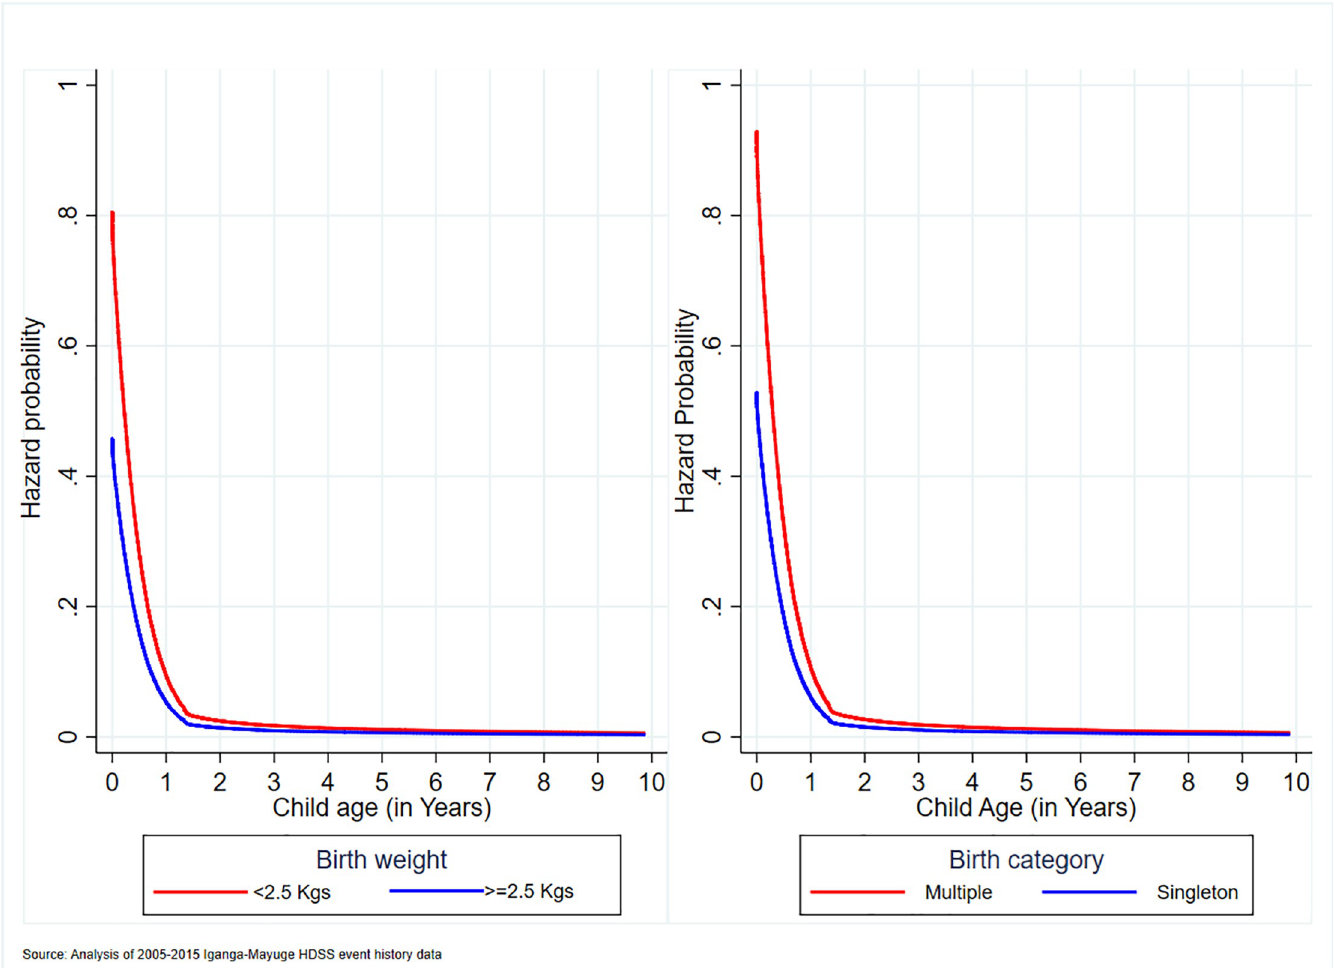
Fig 3. Association of birth weight and birth category with under-10 mortality.